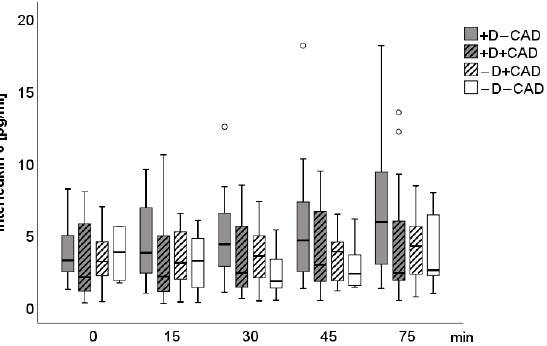
Figure 3. Boxplot of norepinephrine for each measurement time. Circle: ordinary outliner defined as one and a half box-length, asterisk: extreme outliner defined as above one and a half to threefold box-length.